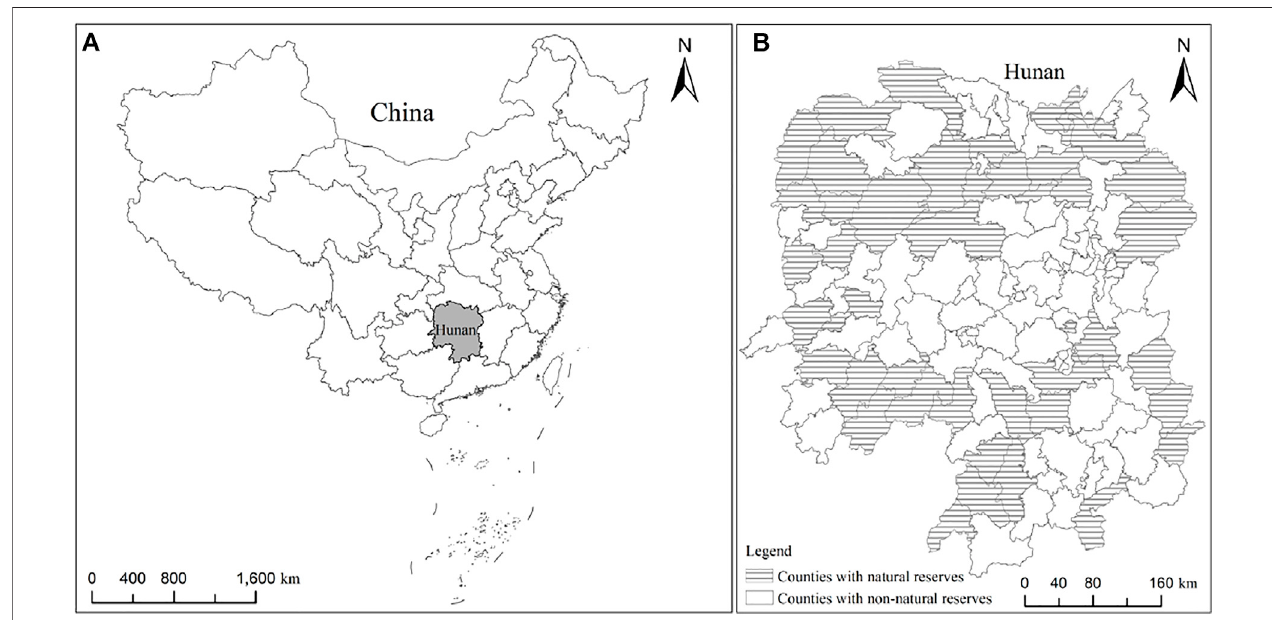
FIGURE 1 | Study area. [Panel (A) : geographical location of the Hunan Province in China. Panel (B) : geographical location of counties with natural reserves and non-natural reserves in Hunan Province in 2020].